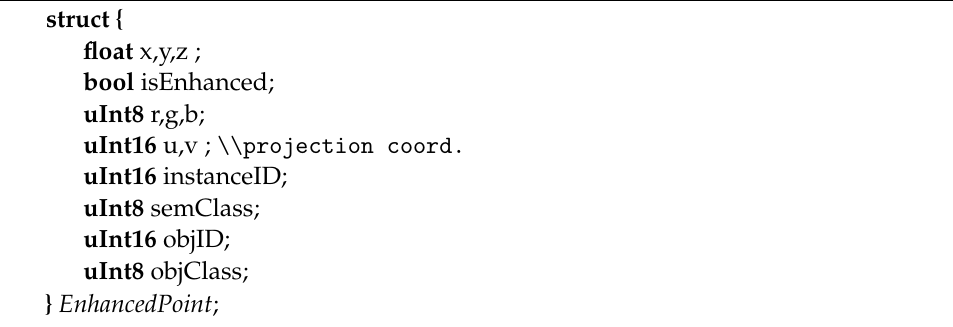
Algorithm 1: STAR 3D point enhancement